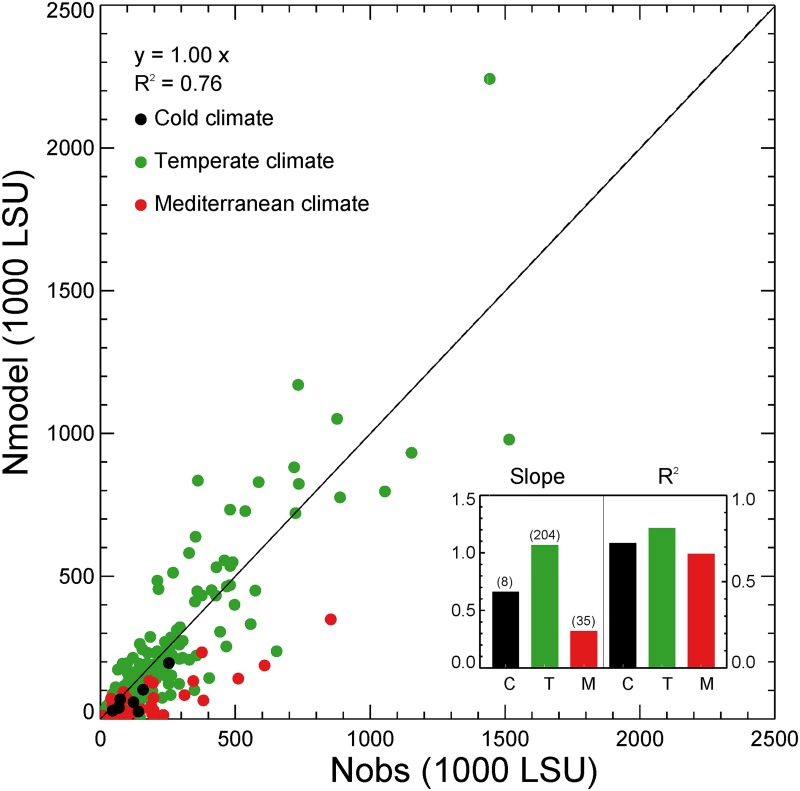
Comparison of modeled (N
model) and ‘observed’ (N
obs) grass-fed livestock numbers (‘observed’ numbers are inferred by combining Eurostat agricultural statistics and additional data in Eq 13) at the scale of each NUTS-2 region for the period 1990–2010 using ordinary least squares linear regression forced through the origin.One point is the average over a NUTS-2 region. A regression coefficient (slope) close to unity with a high coefficient of determination (R2) with P < 0.05 indicates a good model-data agreement. Climate zones follow the Köppen-Geiger classification (see text).